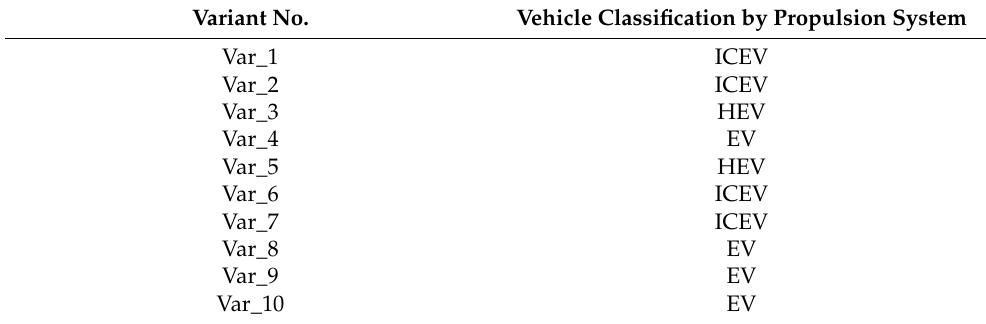
Table 1. Considered decision variants.